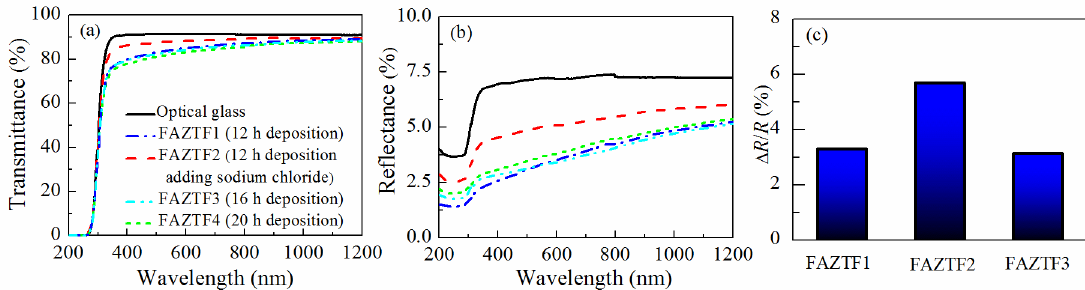
Figure 6. Optical transmittance ( a ) and reflectance ( b ) spectra of FAZTFs deposited at various crystallization times, and reflectance response (dR / R, %) of FAZTFs exposed to acetone vapors ( c ).